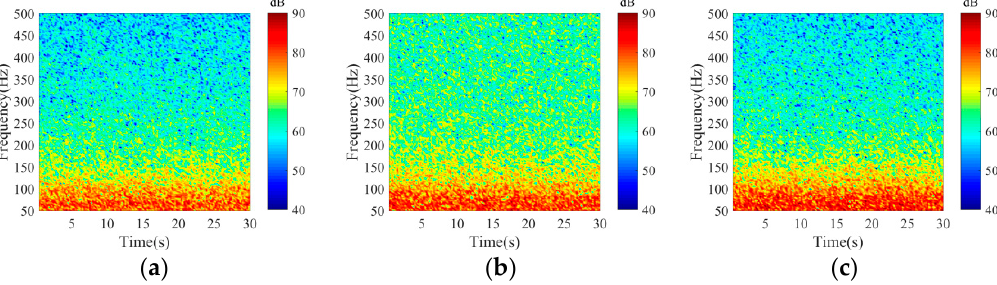
Figure 13. Time frequency spectrogram (unit: dB re 1 μ Pa 2 /Hz) in the experiment for wind speed of ( a ) 7 m/s at 3:00, 13 August, ( b ) 12 m/s at 22:00, 16 August and ( c ) 3 m/s at 3:00, 20 August.